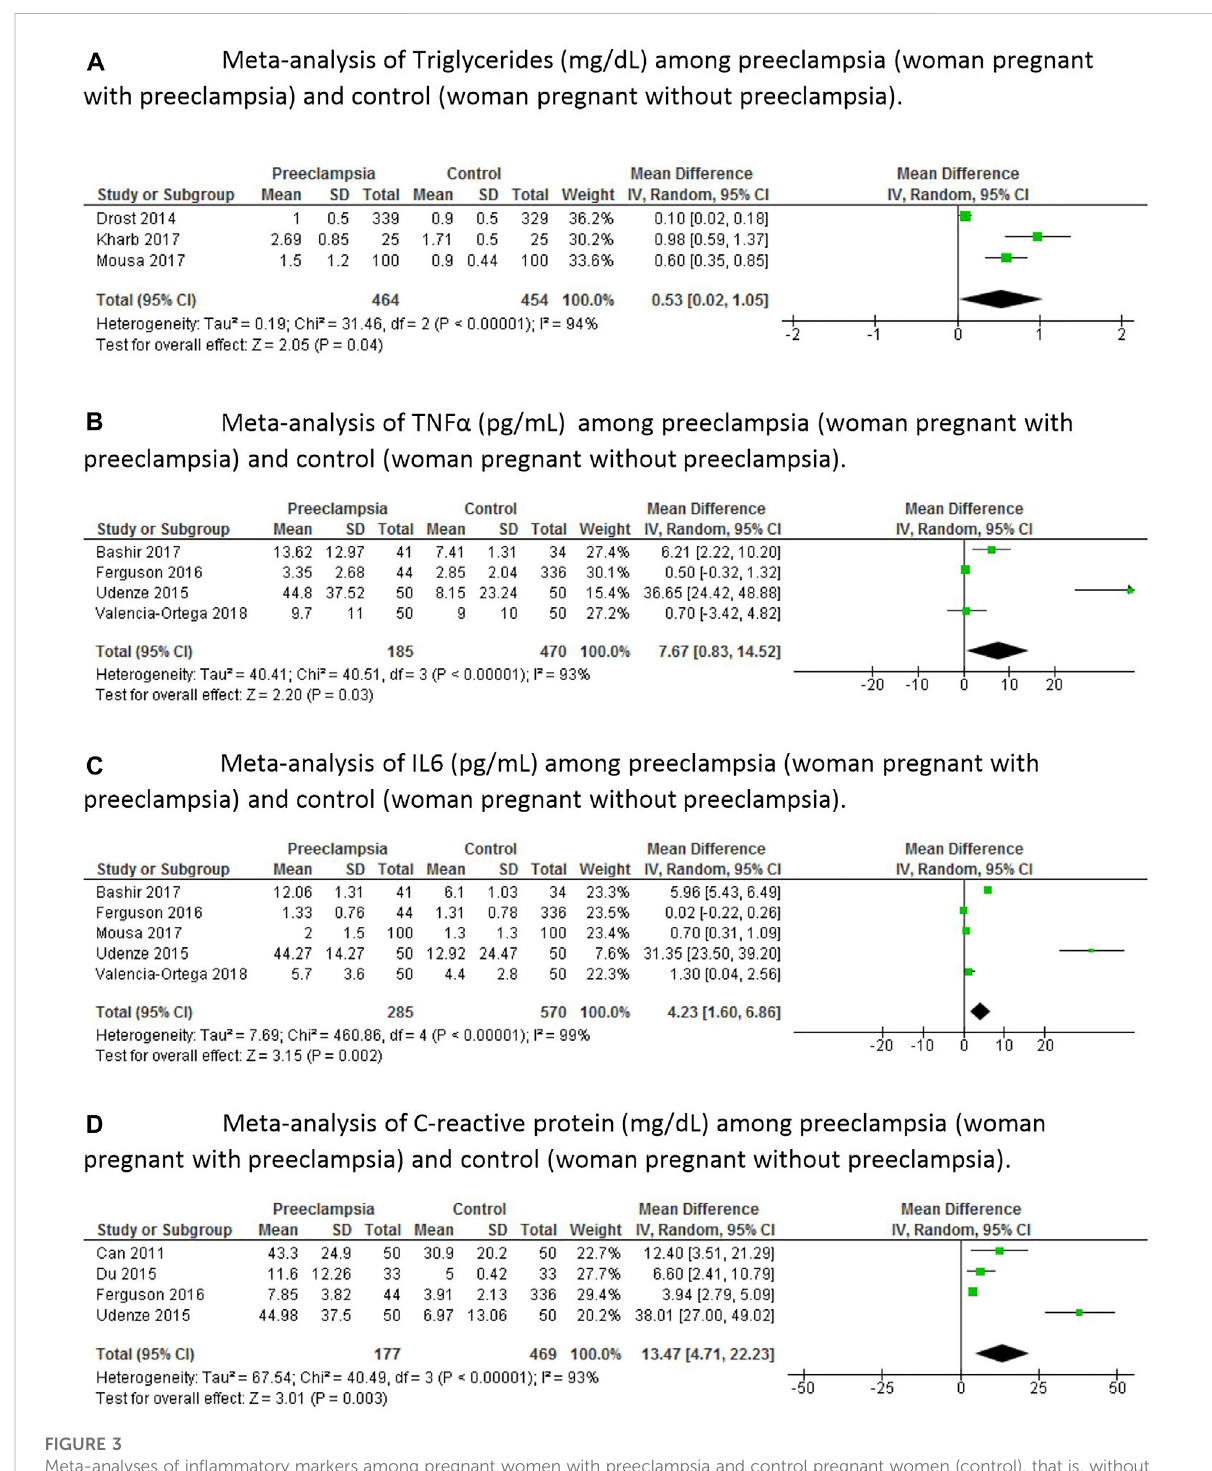
FIGURE 3 Meta-analyses of in fl ammatory markers among pregnant women with preeclampsia and control pregnant women (control), that is, without preeclampsia. (A) — Meta-analysis of Triglycerides (mg/dl) among preeclampsia (woman pregnant with preeclampsia) and control (woman pregnant withoutpreeclampsia). (B) — Meta-analysisofTNF α (pg/ml)amongpreeclampsia(womanpregnantwithpreeclampsia)andcontrol(womanpregnant without preeclampsia). (C) — Meta-analysis of IL6 (pg/ml) among preeclampsia (woman pregnant with preeclampsia) and control (woman pregnant without preeclampsia). (D) — Meta-analysis of C-reactive protein (mg/dl) among preeclampsia (woman pregnant with preeclampsia) and control (woman pregnant without